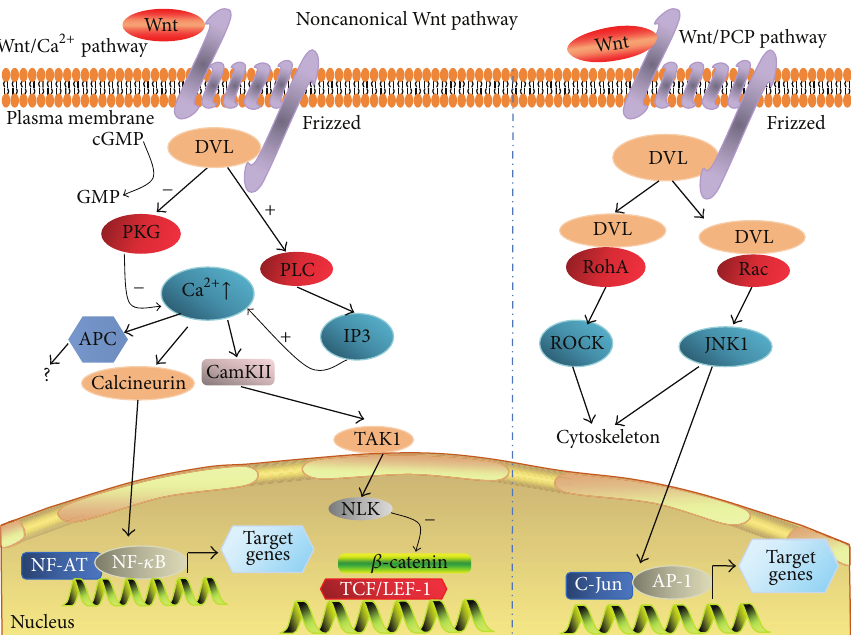
Figure 2: Noncanonical Wnt signaling pathway ( 𝛽 -catenin-independent Wnt signaling pathway). Noncanonical Wnt ligand (such as the Wnt5a, a typical noncanonical Wnt) binds to its receptor (Fzd) and coreceptor (Ror1/2) and triggers the noncanonical signaling cascades, which includes the Wnt/Calcium (Ca 2+ ) and Wnt/planar cell polarity (PCP) pathways. In the Wnt/Ca 2+ pathway (left panel), Wnt protein binds to Fzd and Ror2 receptor and leads to activate G proteins, resulting in enhancing the intracellular calcium levels, or decreases cGMP; the calcium/calmodulin-dependent protein kinase II (CaMKII) or protein kinase C (PKC) was then activated. In the Wnt/PCP pathway (right panel), Wnt proteins bind to Fzd receptors on the cell surface followed by activating Rho/Rac small GTPase and Jun N-terminal kinase (JNK) to assist with cytoskeletal organization and gene